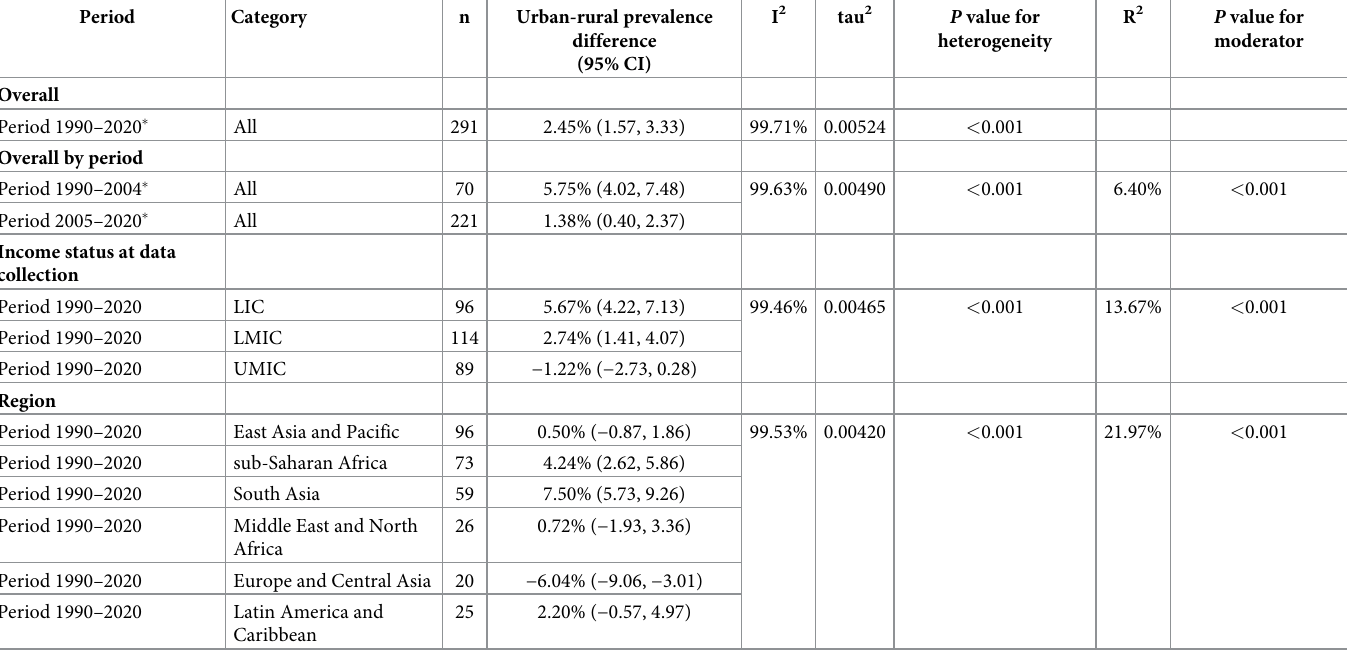
Table 2. Difference in hypertension prevalence between urban and rural areas from the 299 surveys included from 66